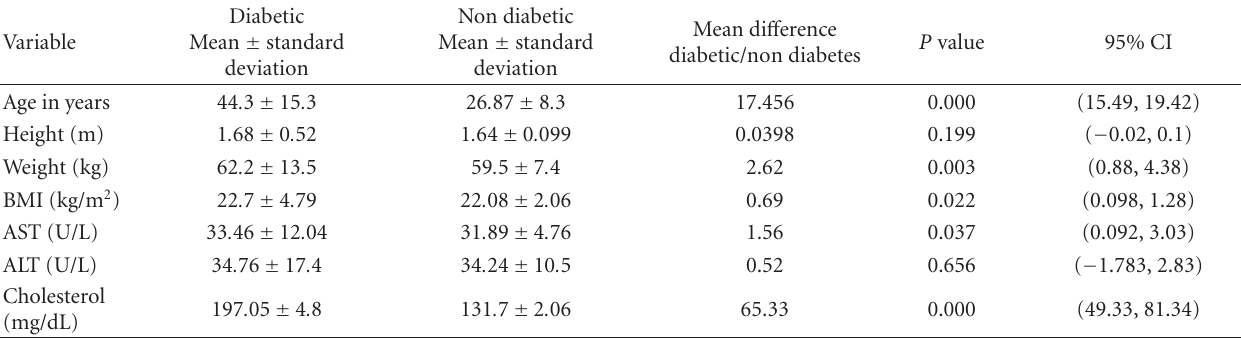
Table 3: Unpaired t -test values for the di ff erence of means between diabetic and non diabetic controls with equal variance is assumed, Jimma University Specialized Hospital, July 2010.